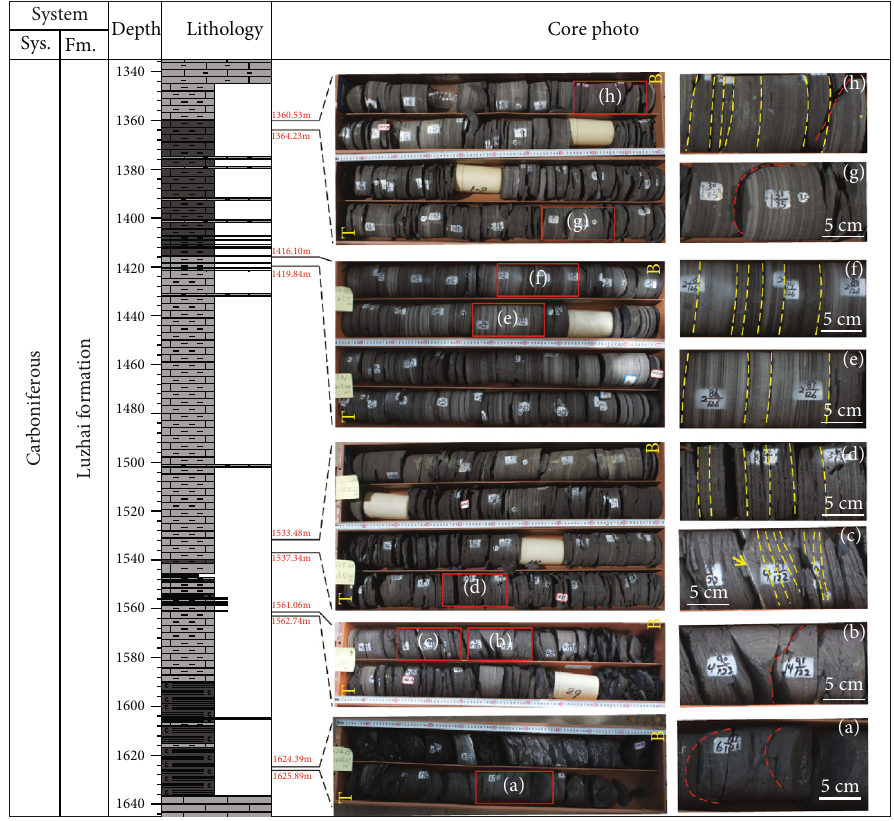
Figure 13: Typical core photos of Lower Carboniferous Luzhai organic-rich shale in well GRY1.